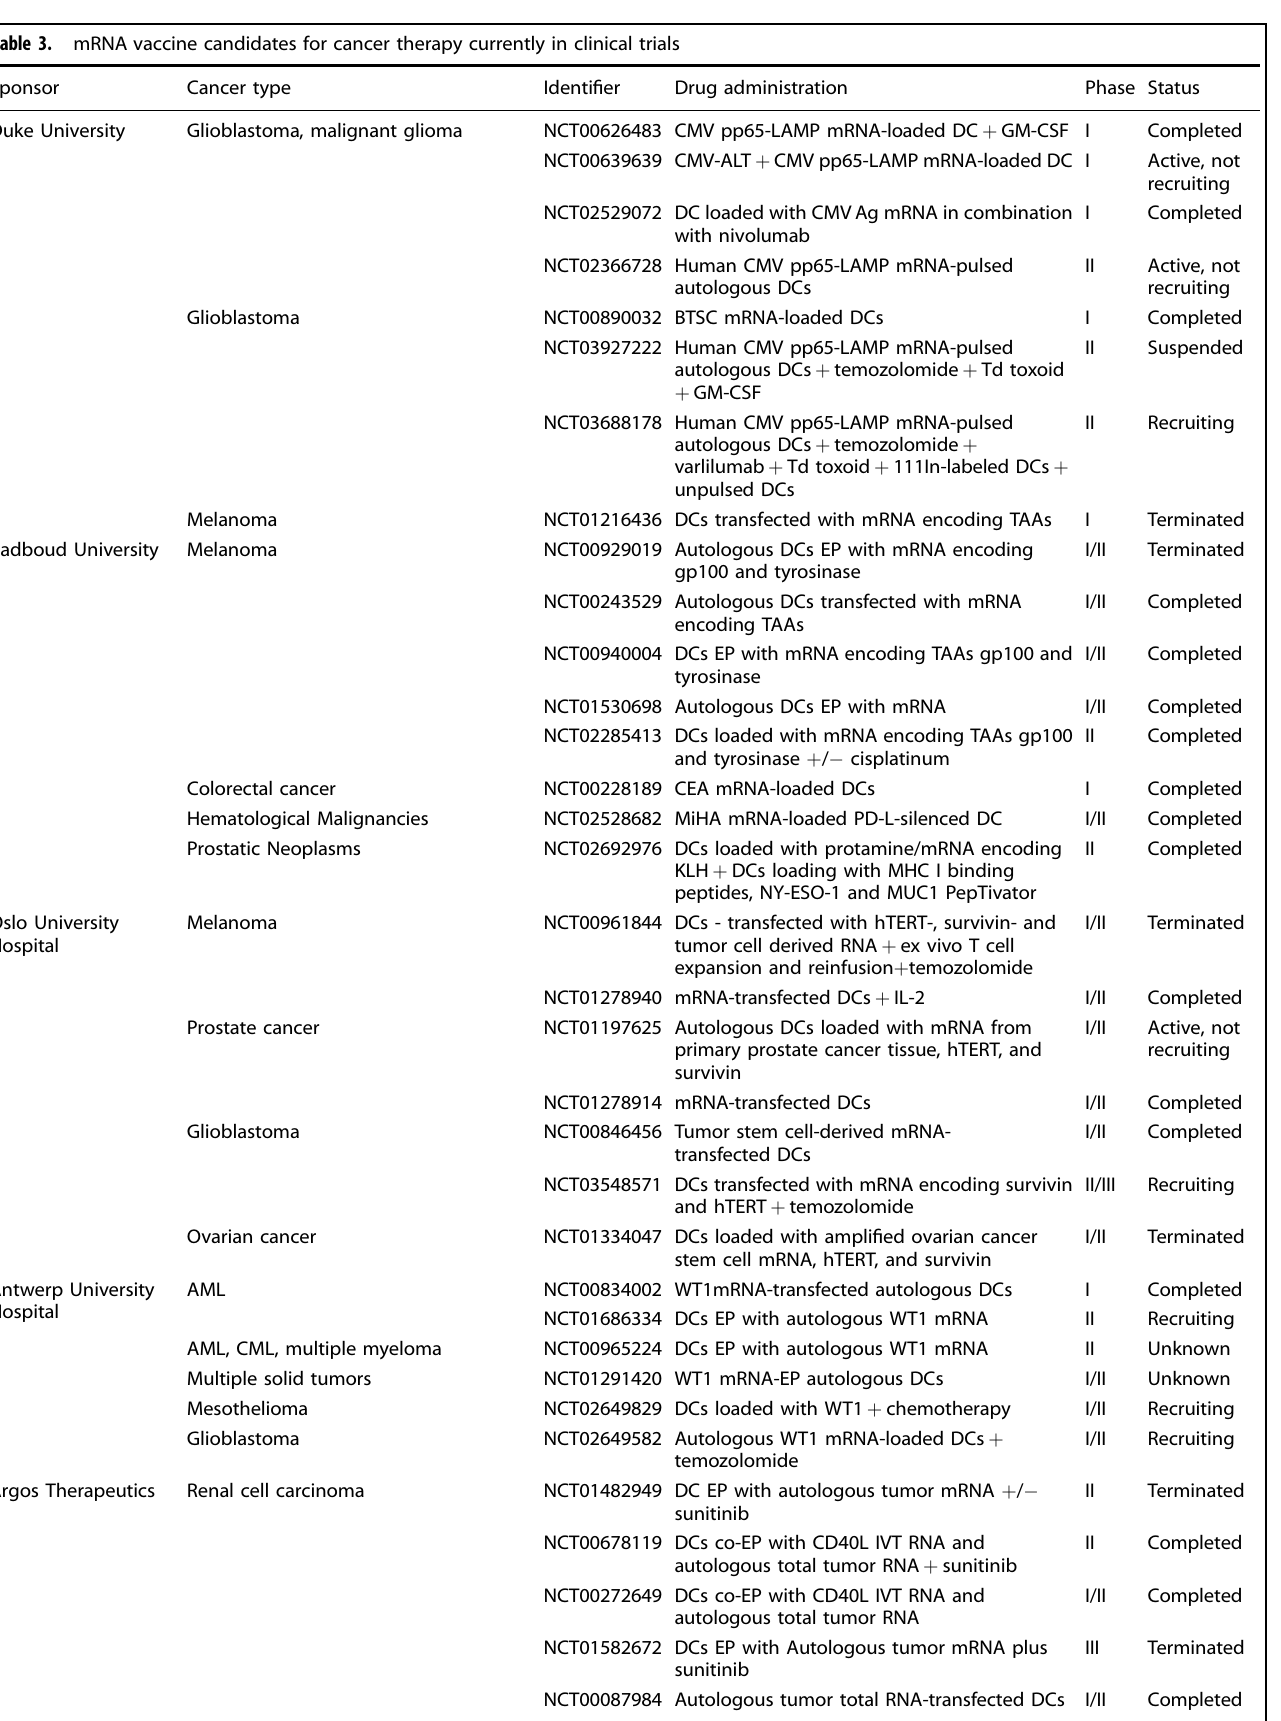
Table 3. mRNA vaccine candidates for cancer therapy currently in clinical